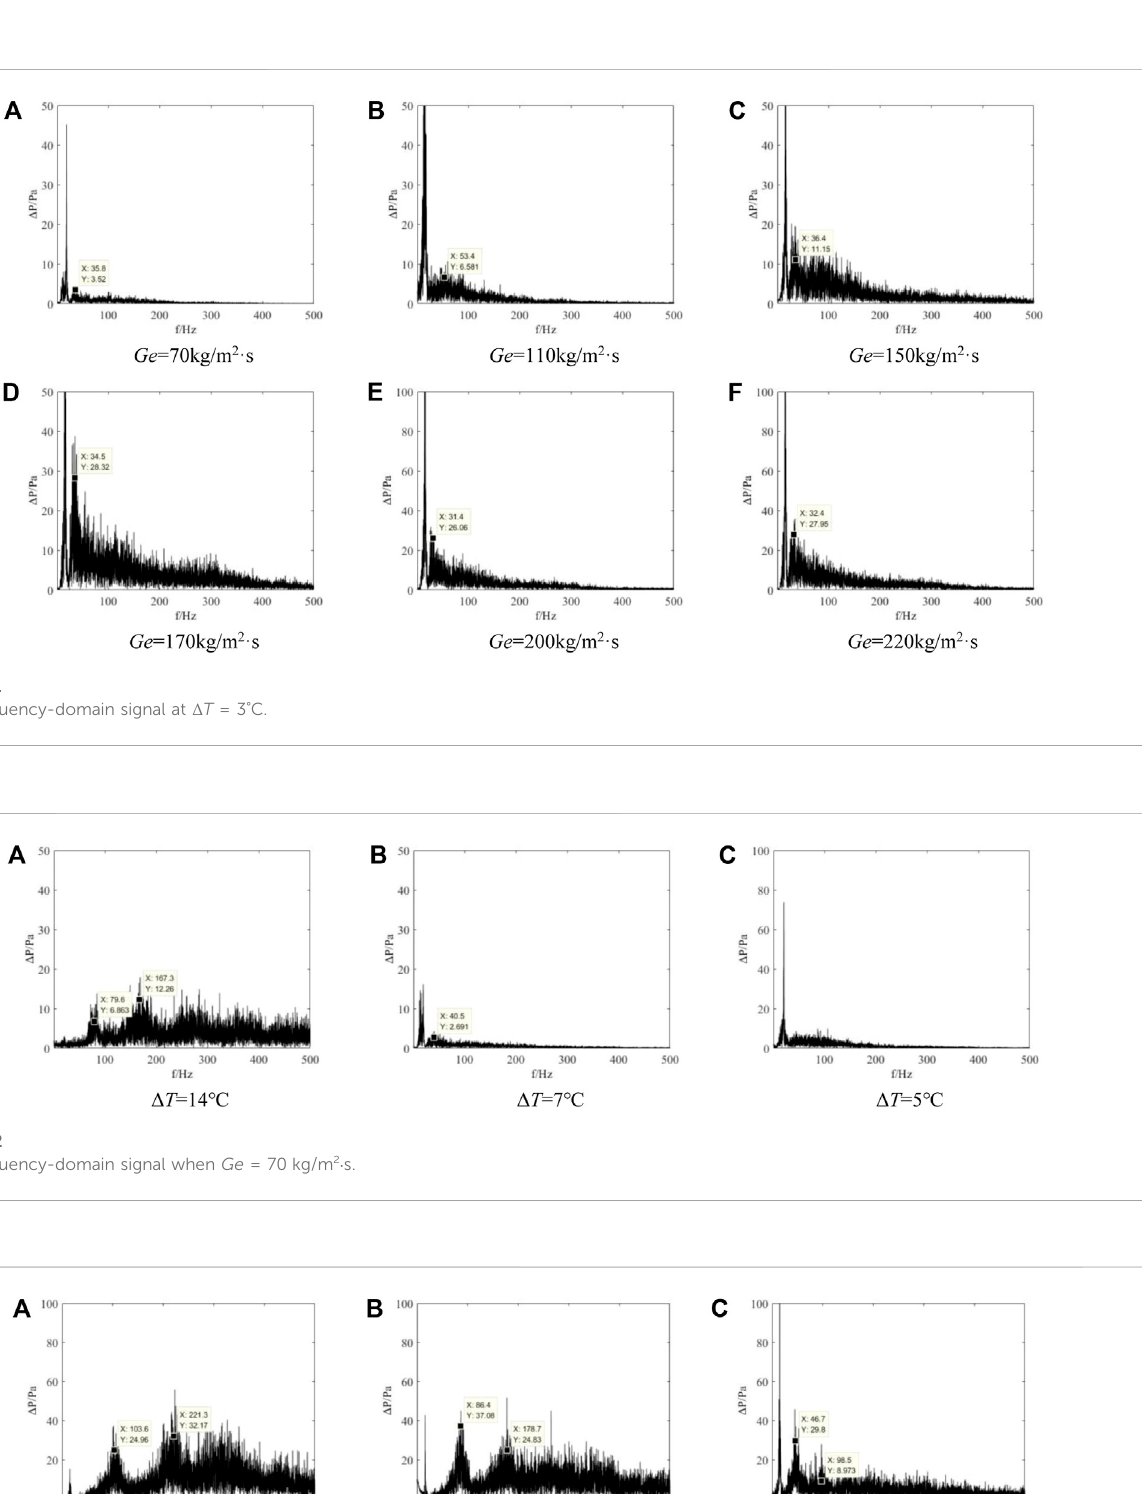
FIGURE 13 Noise frequency-domain signal when Ge = 140 kg/m 2 ·